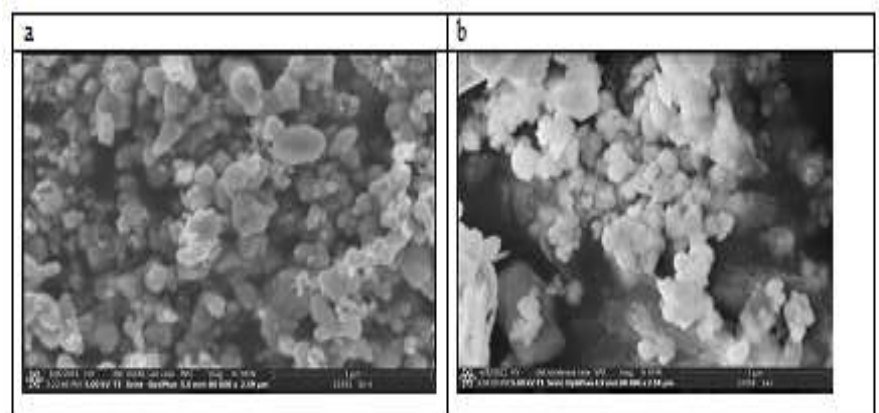
Figure (5): SEM analysis of the surface shape annealing at 500 °C for 120 min: (a) V 2 O 5 and (b) SnO 2 .